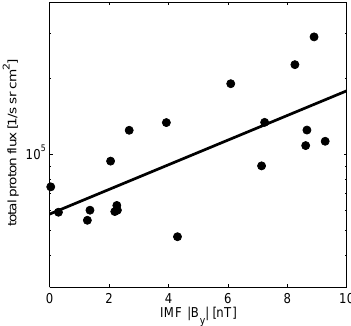
we used is an average of up to three hours before the satel- lite entered a region. This three-hour time lag was used in order to take into account the time it takes for a particle to drift from the tail (where substorm acceleration occurs) to the high-latitude dayside regions.